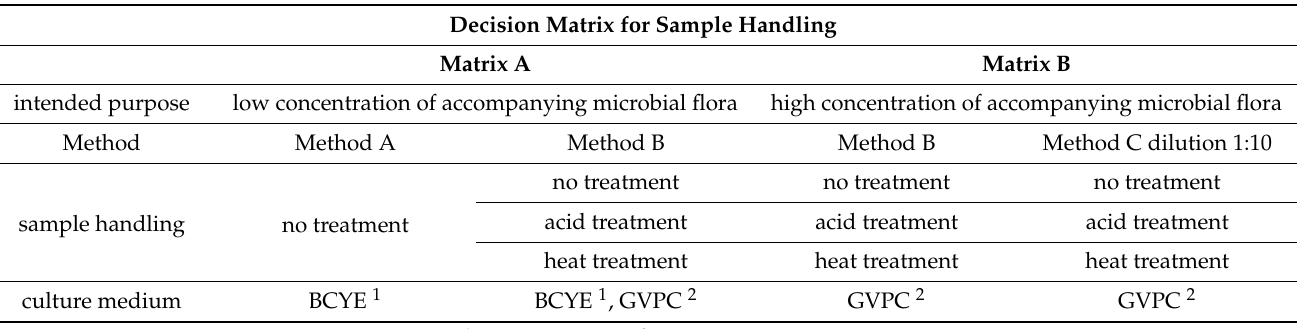
Table 1. Sample handling for Legionella detection by culture, based on ISO 11731:2017. Decision Matrix for Sample